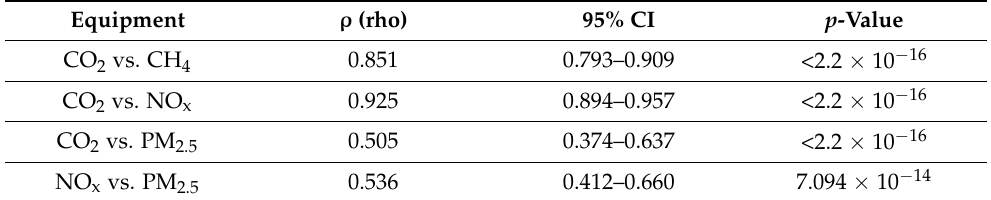
Table 3. Willow Springs campaign Spearman correlation test results for van pollutant